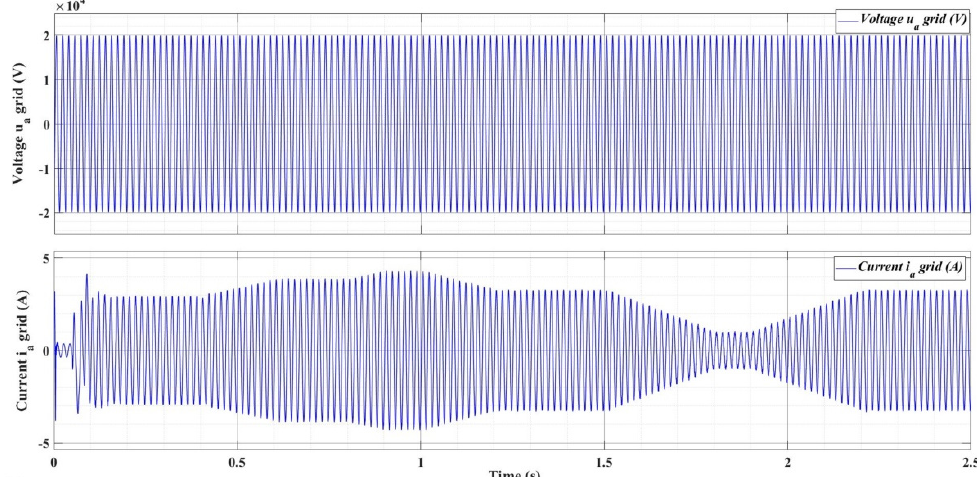
Figure 43. The time evolutions of the P mean and U mean of the PV, the duty cycle of the DC–DC converter and the modulation index of the DC–AC converter (signal evolution of the type 2 PV array).